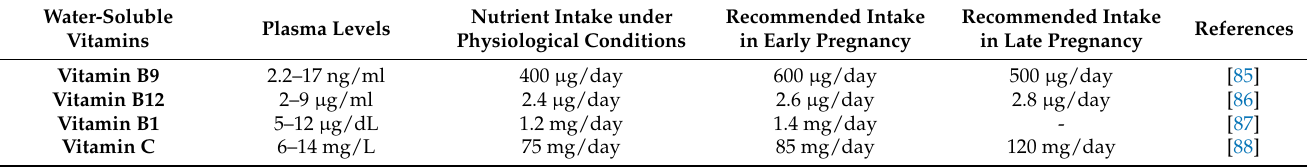
Table 2. Plasma levels and reference values for the intake of water-soluble vitamins B9, B12, B1, and C. Water-Soluble